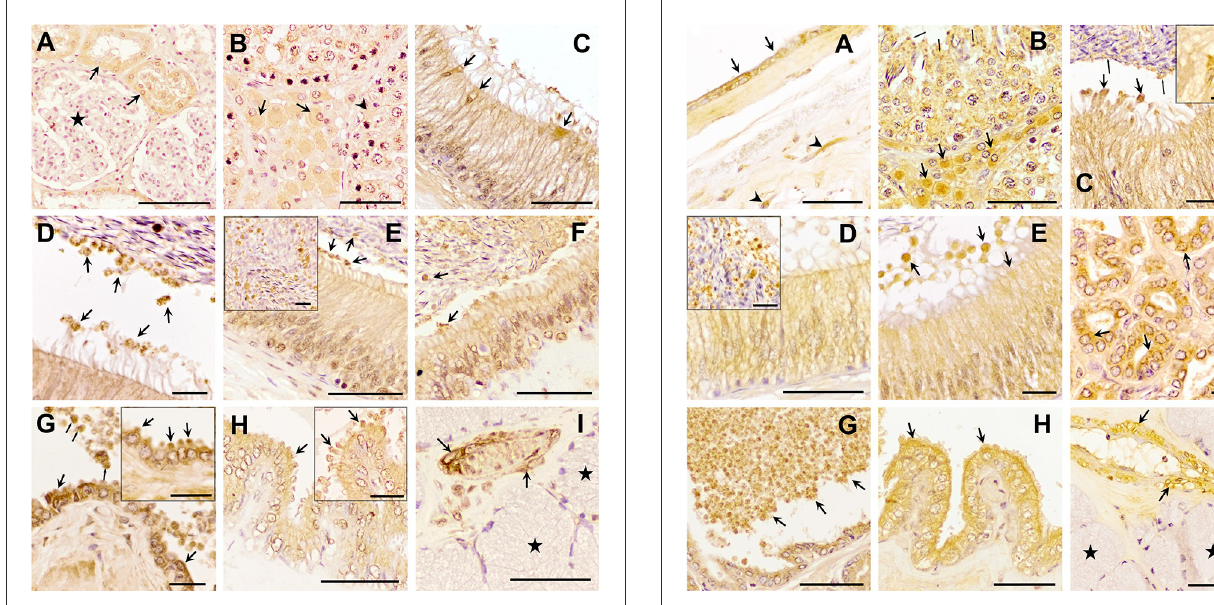
FIGURE2 Immunohistochemistry of Transforming Growth Factor (TGF)- β 1 in pig male reproductive tissues. Immunolabelling in (A) pig kidney (positive control), present in the cytoplasm of the cells of the distal tubules (arrows) but not in renal corpuscles (stars); (B) testes, in the cytoplasm of some of the Leydig cells (arrows) and Sertoli cells (arrowhead); (C, D) caput epididymis, in clear cells and in large and small vesicular structures; (E, F) corpus and cauda epididymis, in vesicular structures close to the stereocilia of principal cells and to spermatozoa (arrows); (G) prostate, in luminal vesicles (thin arrows) and in the cytoplasm of the epithelial cells (in detail their apical blebs, thick arrows); (H) seminal vesicle, in apical blebs of epithelial cells (arrows); (I) bulbourethral gland, in vascular smooth muscle (arrows), but not in secretory epithelium (stars). Scale bars, (A–C, E, F, H, I) 50 µ m; (D, G) 20 µ m; and (E, G, H) detail 20 µ m.